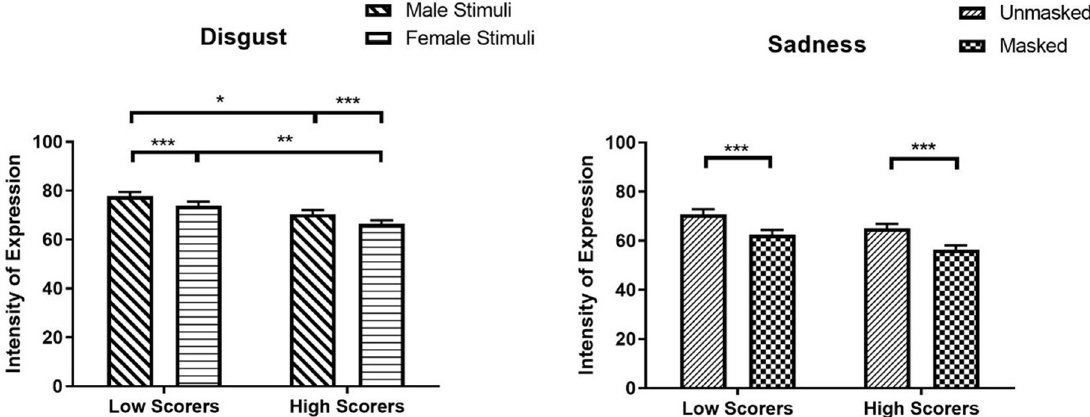
Fig 8. Intensity of expression ratings for disgust and sadness as a function of mask and AQ-10. � p < 0.05, �� p < 0.01, ��� p < 0.001.